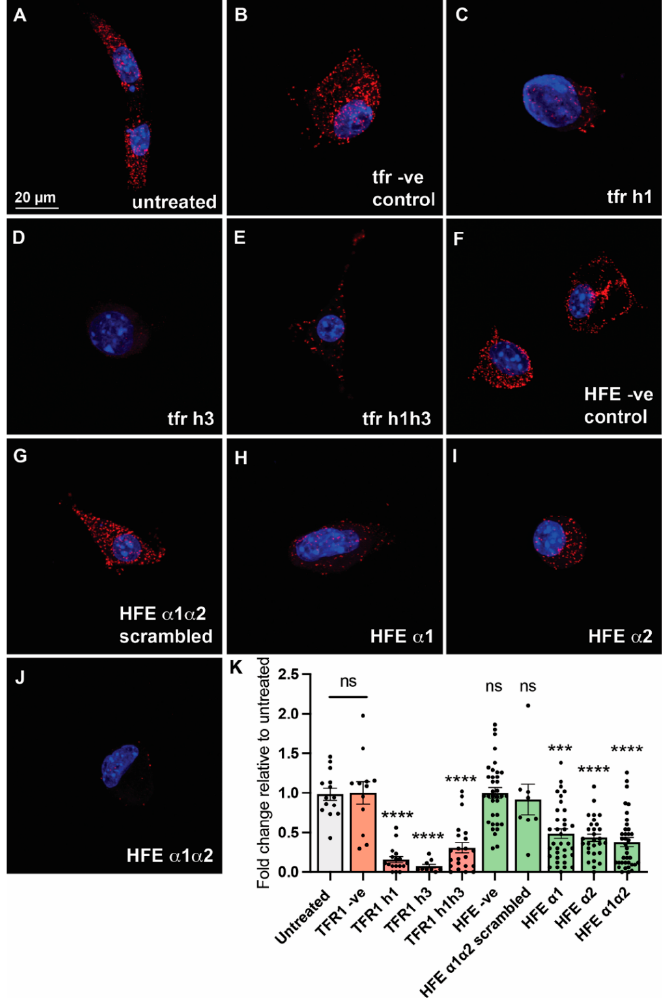
Figure 3. Imaging and quantification of the proximity ligation assay of HFE- and TFR1-like peptides in mouse liver Hepa 1–6 cells. The sharply bright red spots correspond to TFR1 in complex with HFE. ( A ) Untreated cells; ( B ) TFR1 negative control peptide designed from the outside of the binding interface of HFE and TFR1; ( C – E ) TFR1-like peptides corresponding to TFR1 h1, TFR1 h3 and TFR1 h1h3, respectively; ( F ) HFE negative control peptide designed from the outside of the binding interface of HFE and TFR1; ( G ) negative control peptide corresponding to a scrambled sequence of HFE α 1 α 2; ( H – J ) HFE-like peptides corresponding to HFE α 1, HFE α 2, and HFE α 1 α 2, respectively; and ( K ) bar scatter plot showing the number of red spots per cell quantified using IMARIS ® 8.2.0 and normalised. All peptides (other than negative control and scrambled peptides) successfully reduced the number of HFE-TFR1 complexes found per cell with respect to untreated cells (n ≥ 9. One-way ANOVA with Tukey’s test, **** p < 0.0001, *** p < 0.0002).